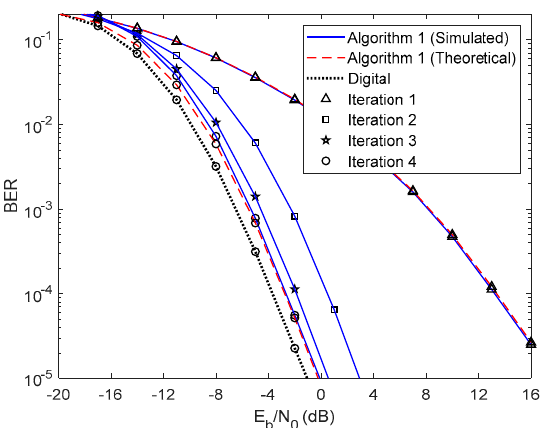
Figure 8. Performance comparison between the Algorithm 1, the two-step and GS/MMSE approaches for the PCSI precoder with ULA configuration and 16 QAM modulation.